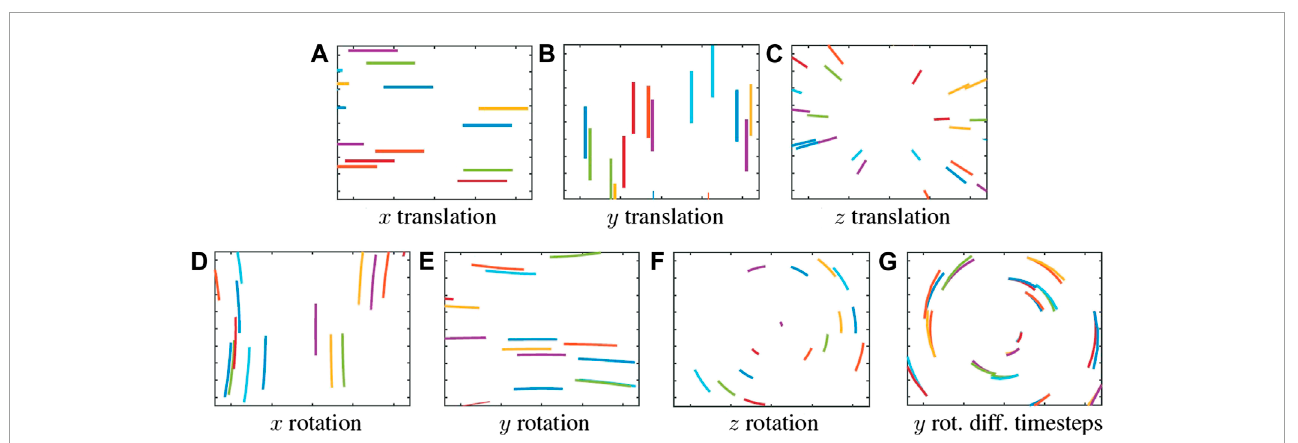
FIGURE 3 Overview of the proposed approach.